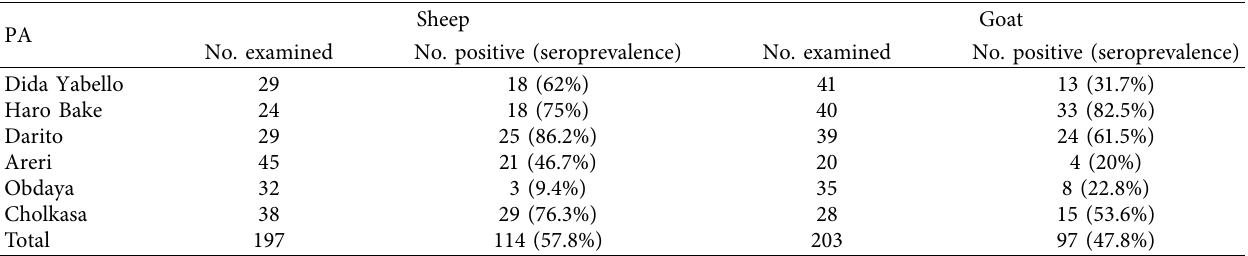
Table 3: Seroprevalence of T. gondii antibody and logistic regression output of risk factors and variables for sheep. Risk factor/variable